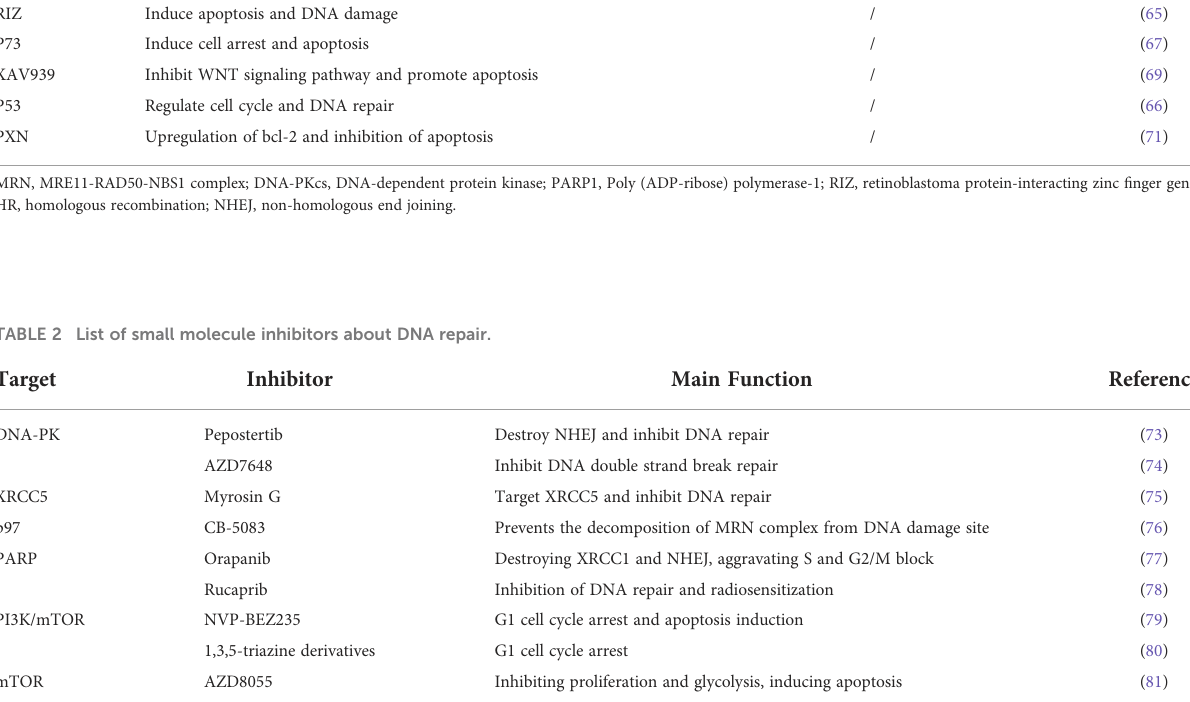
DNA-PKcs, DNA-dependent protein kinase; XRCC5, X-ray repair cross complement protein 5; PARP, Poly (ADP-ribose) polymerase; NHEJ, non-homologous end joining.